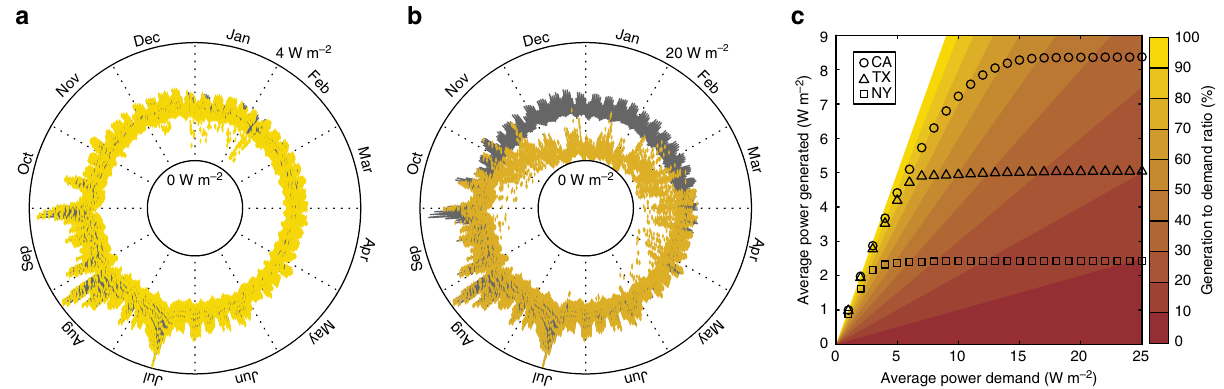
Fig. 5 The relationship between reliability and average power output. The demand ( gray line ) and generation ( dots ) for ( a ) 2 W m − 2 and ( b ) 10 W m − 2 annual average demand targets for the fi nal simulation year in California. In a , generation matches demand 95% of the time with 99% annual generation to demand ratio. In b , generation matches demand 48% of the time with 71% annual generation to demand ratio. c Predicted average power generation as a function of target power demand for California ( circles ), Texas ( triangles ), and New York ( squares ) test locations. The overlaid contour map is the resulting generation to demand ratios at each power demand condition for that speci fi c average power generation. These simulations predict that the maximal generation is 2.4, 5.1, and 8.4 W m − 2 for the respective New York, Texas, and California test locations